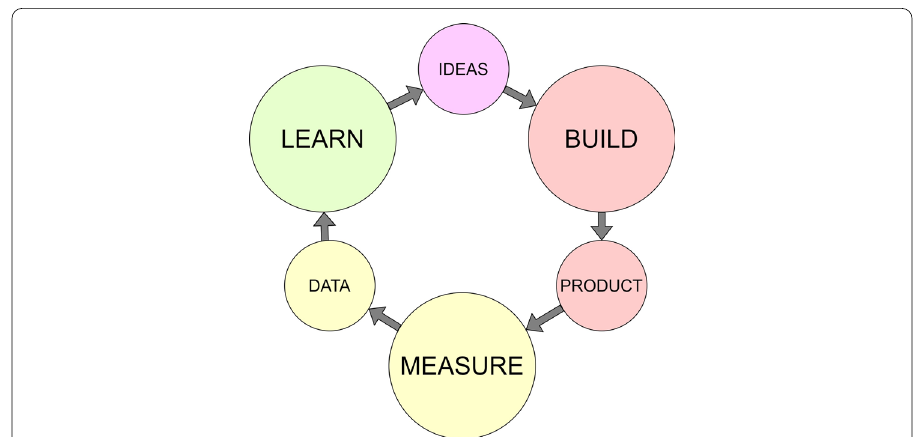
Fig. 1 Build–measure–learn feedback loop (adapted from Ries, 2011, p. 75)